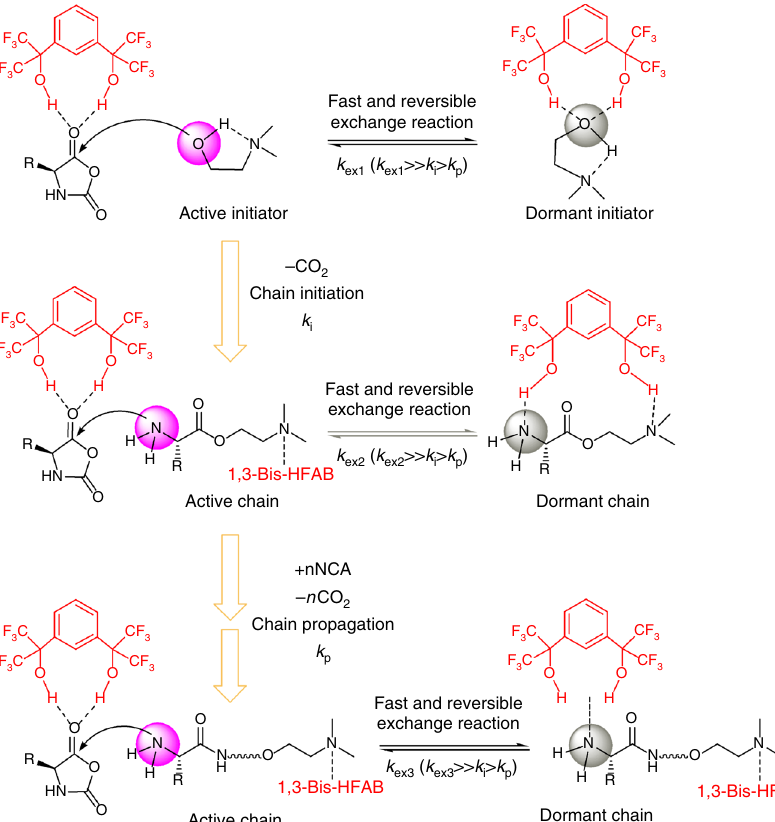
Fig. 7 Proposed mechanism of ROP of Glu-NCA catalyzed by 1,3-Bis-HFAB. The nucleophilic ring-opening of the NCA by DMEA in the presence of 1,3-Bis- HFAB leads to the initiation of polymerization, whereby the ring-opened NCA releases one carbon dioxide molecule and forms the propagating amine for the subsequent addition of NCA monomers. During polymerization, multiple hydrogen-bonding equilibriums involving NCA monomer, initiator (DMEA), catalyst (1,3-Bis-HFAB), and propagating polymer chain exist. The catalysis proceeds by simultaneous activation of the carbonyl of NCA monomer and dynamic protection of the polymer chain-end amine group via hydrogen bonding to 1,3-Bis-HFAB automatic sampling interval is 10 s. The real-time concentration of NCA was wavenumber resolution and the automatic sampling interval is 10s. When full quanti fi ed by measuring the intensity of NCA ’ s anhydride peak at 1792 cm − 1 . conversion was achieved from the in situ FT-IR spectra, 0.2 mL of the reaction Polymer characterizations were carried out by using Agilent 1260 in fi nity SEC mixture was taken out from the reaction system and diluted to 10 mg/mL by using instrument. The fractionation module was connected with three different detectors HPLC-grade DMF (containing 0.1 M LiBr). The solution was then used for SEC (from Wyatt Technology), Optilab T-rEX RI detector, ViscoStar-II viscometer and DAWN HELEOS-II multiangle laser-light scattering (MALLS) detector at a laser wavelength of 690 nm. Three 7.8× 300 mm columns (Styragel ® HT 2 DMF, Styr- agel ® HT 3 DMF and Styragel ® HT 4 DMF) and one guard column were used for polymer fractionation. The columns were calibrated with a series of polystyrene standards (Polymer Standard Service, U.S.A.). HPLC-grade DMF (containing 0.1M LiBr) was used as the mobile phase at a fl ow rate of 1.0mL/min. The whole SEC system was equilibrated in mobile phase at 60 °C. Polymer solutions with concentrations between 5.0 and 10.0 mg mL − 1 were injected with an injection volume of 200 μ L. ASTRA software from Wyatt Technology was used for the data collection and analysis. The absolute molecular weights of resultant polypeptides were calculated with dn/dc values (dn/dc(PBLG) = 0.104 mLg − 1 , dn/dc(PZLL) = 0.123 mLg − 1 , dn/dc(PABLG) = 0.126 mL g − 1 , dn/dc(PBLG-co-PZLL) = 0.114 mLg − 1 , dn/dc(PBLG-co-PABLG) = 0.115 mLg − 1 . PBLG, PZLL, and PABLG represent polypeptides obtained from ROP of Glu-NCA, Lys-NCA and Alkynyl- NCA, respectively.) The Density Functional Theory (DFT) calculation was per- formed at the GGA/PBE/DNP level of theory. All of the constructed structures are fully optimized and electrostatic potential (ESP)- fi tting charges are derived from the DFT calculation. Polymerization procedure . A typical procedure for the ring-opening poly- merization of NCA was performed at 25°C in a Braun Labmaster glovebox. Before polymerization, an attenuated total re fl ectance (ATR) diamond probe was con- nected to the reaction fl ask via a AgX Fiber (Silver Halide, 9.5 mm× 1.5m). A standard ISO 10993-12:2012. The cellular toxicity of the polypeptide samples was solution of the initiator (DMEA) and catalyst (1,3-Bis-HFAB) in 4 mL of reaction evaluated as follows. HepG2 cells were fi rstly seeded in 96-well plates with a density solvent (DCM) was fi rstly added into the fl ask. After stirring at 25 °C for 1min, the of 5× 10 3 cells per well and incubated overnight. Subsequently, the cells were monomer solution of 0.4 g Glu-NCA monomer in 4 mL DCM was then quickly incubated for 48 h with various concentrations of the extract of polypeptides. added into the fl ask to start the polymerization and the auto sampling system was Afterwards, the cytotoxicity was evaluated by adding Cell Counting Kit-8 (CCK-8) switched on immediately. Sampling is from 2800 cm − 1 to 650 cm − 1 at 8 solution (from RayBiotech, Inc.) to each well of the plate. After incubation for 1h, NATURE COMMUNICATIONS| (2019) 10:3590